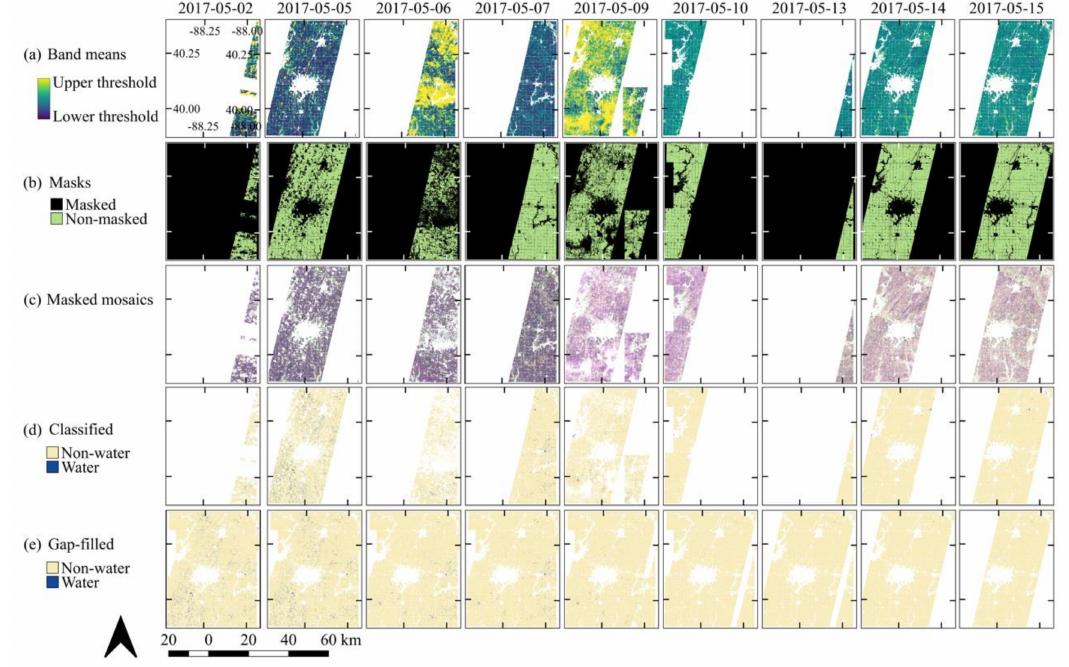
Figure 4. County-scale raster data and results for Champaign County, Illinois, USA. ( a ) We used means of all spectral bands at each pixel to determine cut-o ff values for a simple exclusion of clouds and cloud shadows. ( b ) Obscurations such as clouds or 150-m bu ff ers surrounding cloud shadows were masked out in addition to land cover types not classified as maize, soybeans, or water surface according to the 2017 Cropland Data Layer (CDL). ( c ) Mapping the spectral bands to the false-color display as red to red, near infrared (NIR) to green, and blue to blue allows for the discrimination of water surfaces during the assembly of polygons for training the algorithms. ( d ) In the classification images, yellow represents valid, available data that were classified as not water and blue represents surfaces classified as water, with the same representation in ( e ) the gap-filled data. The gap-filled data excludes permanent water bodies identified from the 2017 CDL. Due to the missing data from masking out clouds and cloud shadows, the spatiotemporal analysis is an underestimate of the actual ponding dynamics of this